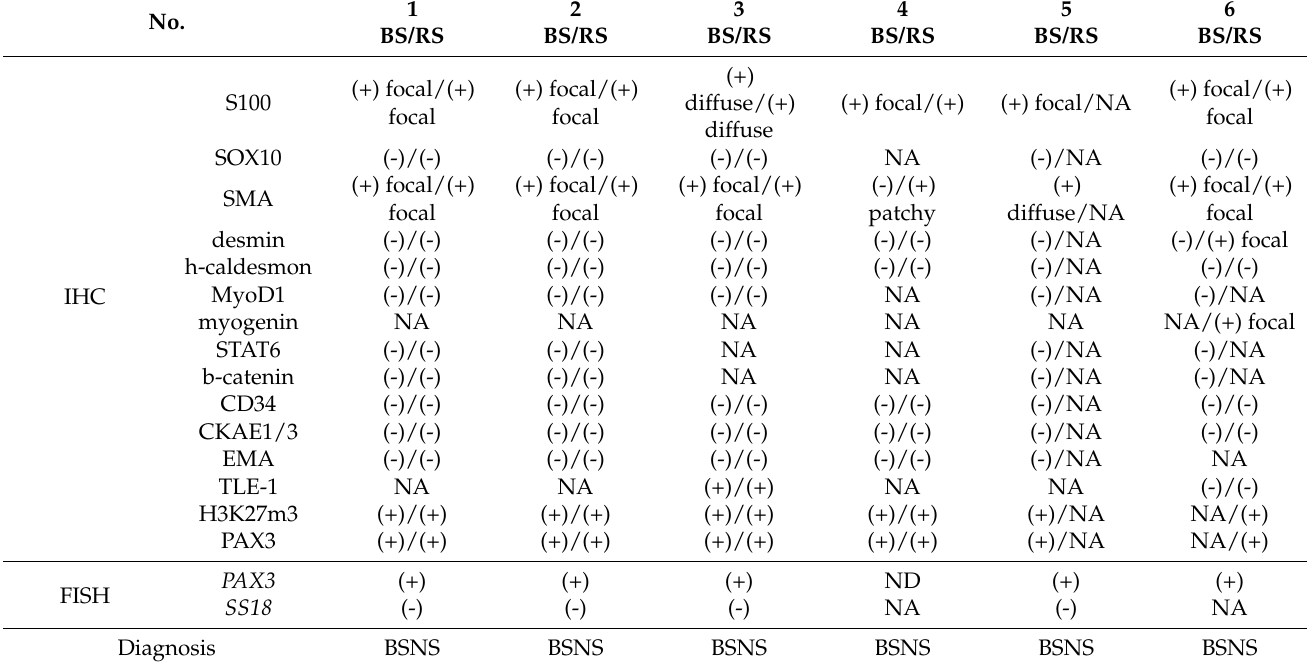
Table 3. IHC and FISH findings in incisional biopsy and resection